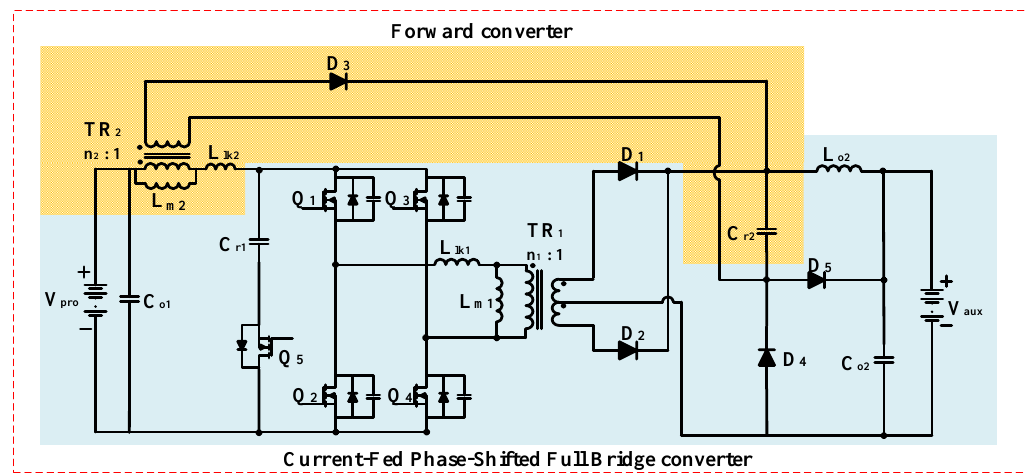
Figure 2. LDC converter of the proposed integrated OBC.